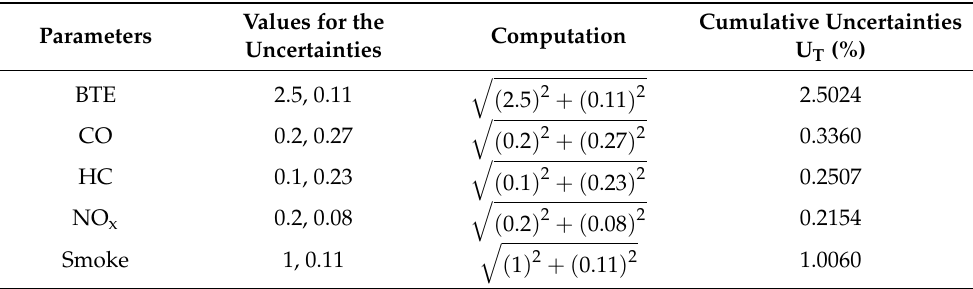
Table 7. Total uncertainty values obtained taking uncertainty values of the measuring instrument and the proposed ANN